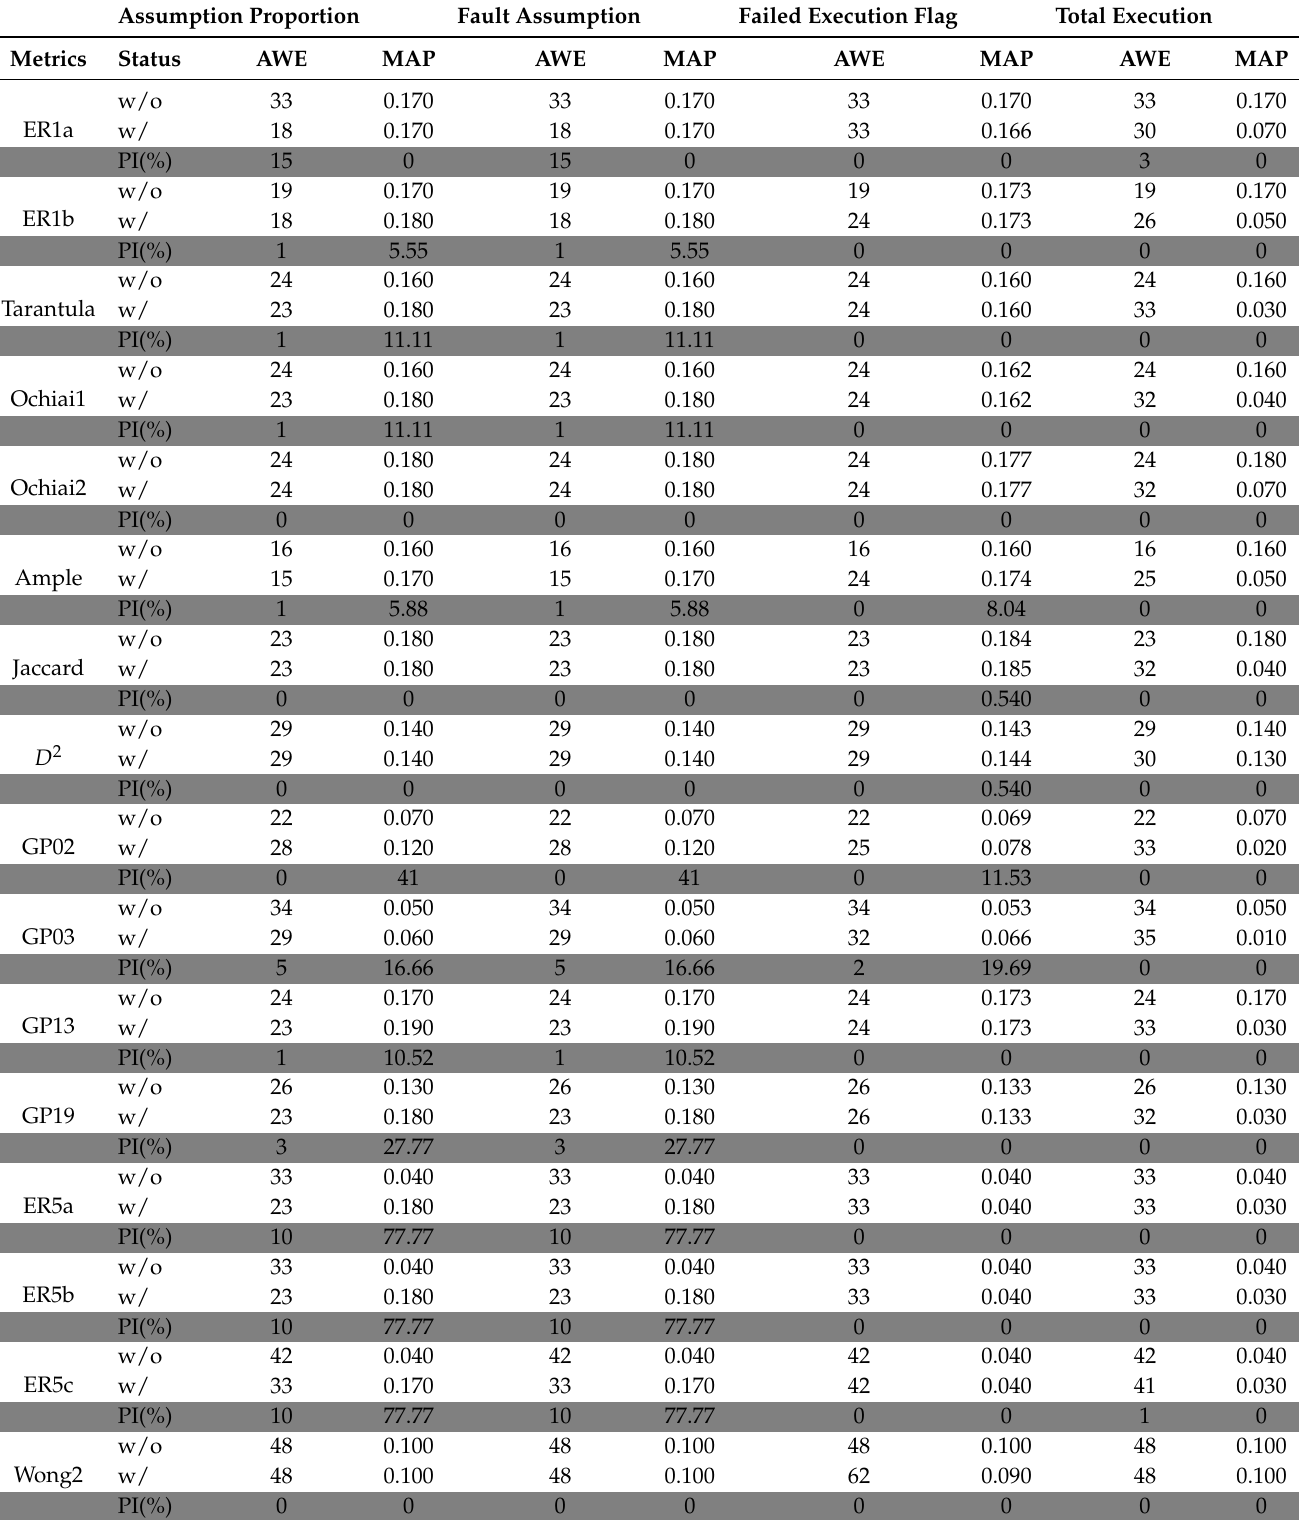
Table 6. Mean Average Precision and Wasted Effort of the existing formulas with and without Assumption Proportion (P), Failed Execution Flag (F), Fault Assumption (A), and Total Execution (E) in seeded and real faults. PI: Percentage of Improvement. w/o: without metric. w/: with